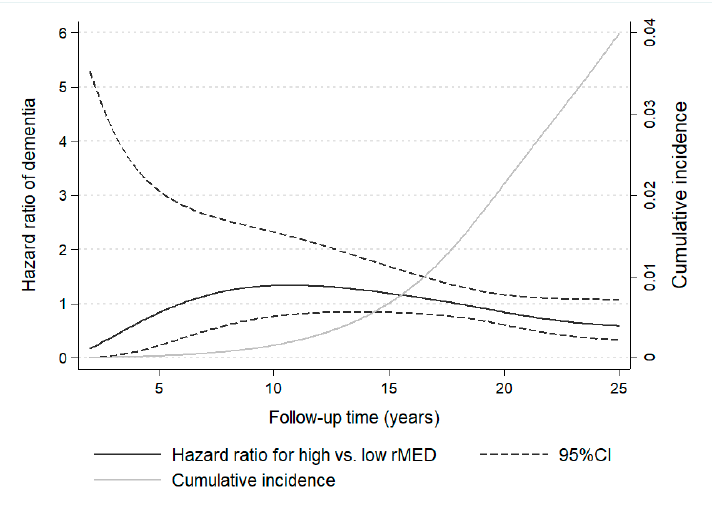
Figure 2. Time-dependent variation in hazard ratio estimates of dementia for participants with high versus low Mediterranean Diet scores (rMED) throughout 25 years of follow-up in the